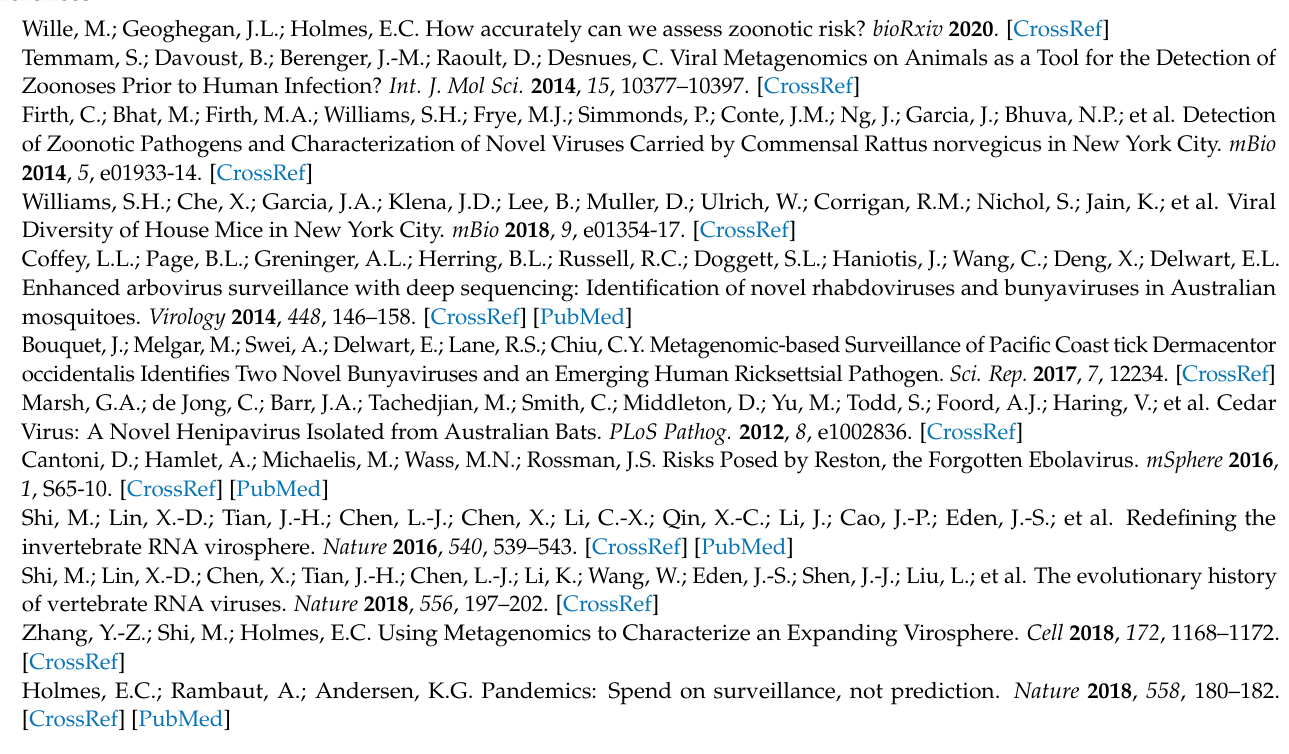
Supplementary Materials: The following are available online at https://www.mdpi.com/1999-491 5/13/2/252/s1. Figure S1: Schematic depiction of novel viral genomes discovered in vampire bats; Figure S2: Hepeviridae full genome phylogeny; Figure S3: Hepeviridae RdRp phylogeny; Figure S4: Coronaviridae RdRp phylogeny; Figure S5: Reoviridae VP6 phylogeny; Figure S6: Astroviridae phy- logeny; Figure S7: Picornaviridae phylogenies; Figure S8: Effect of discrete clusters of correlated features on predicted scores for Hepeviridae and Parechovirus -like Picornaviridae ; Table S1: Metage- nomic datasets from which novel vampire bat viruses were characterized; Table S2: Viral sequences examined in this study, sampling details, and associated Genbank and ENA accessions; Table S3: Genbank accessions, viral family and host for viral taxa included in phylogenies; Table S4: Pairwise identities for each segment between novel vampire bat RVH sequences, the closely related human RVH B219, and bat RVH which was not included in the phylogeny; Table S5: Similarities between Parechovirus -like sequences in vampire bats from different